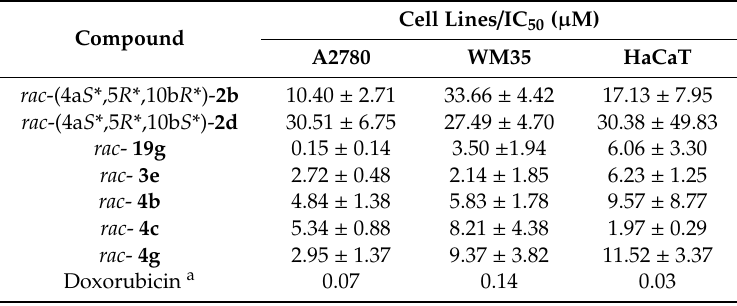
Table 2. In vitro antiproliferative activity of the condensed O,N -heterocycles and the 19g precursor against A2780 and WM35 cell lines determined by MTT assay. Compound